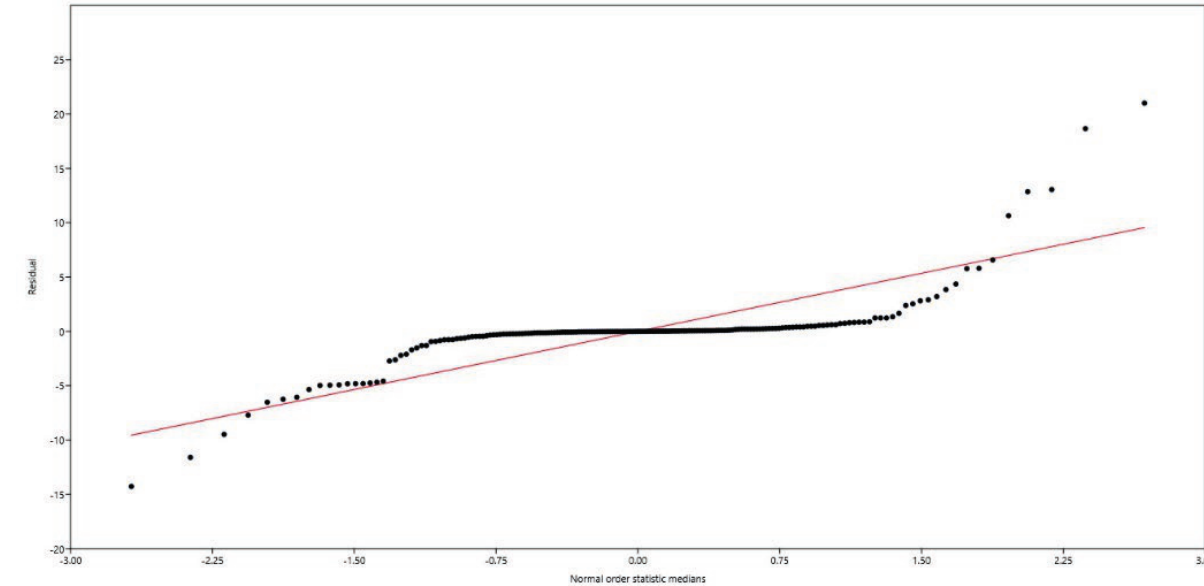
Figure 2. Shapiro - Wilk normality test(p=0.4809>0.05)-Residual plot.